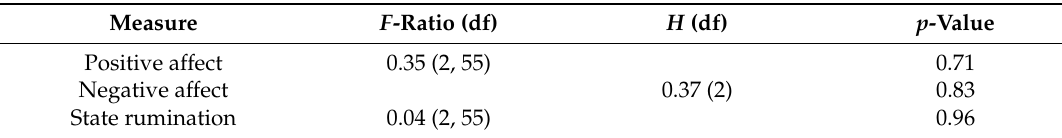
Table 4. Significance Tests for Post-Presentation